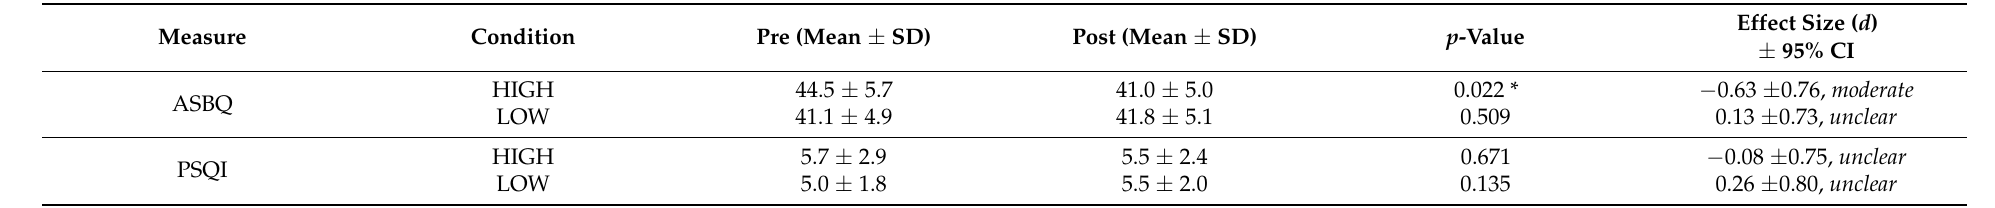
Table 4. Data (mean ± 95% confidence limits) for pre- and post-global scores for ASBQ and PSQI sleep questionnaires between week 1 and week 3 for the HIGH and LOW sleep groups, including p -values and effect size comparisons between time